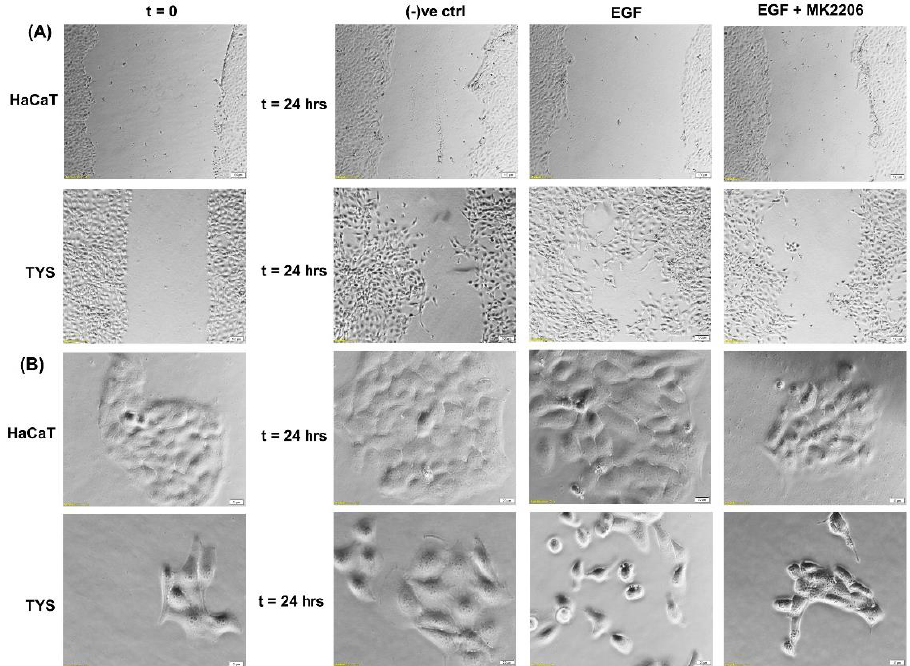
Figure 3. Effect of EGF on oral cancer cell migration. ( A ) A wound was created manually on the cell monolayer as previously described [61] and treated with the EGF with or without the inhibitor for 24 h. EGF stimulated oral adenoid cancer cells (TYS) to close the gap in the wound healing assay (collective cell migration) compared to the negative control. The Akt inhibitor, MK2206, effectively blocked EGF-induced oral cancer cell migration. Normal keratinocytes (HaCaT) were not stimulated to close the gap in response to EGF. Serum-free medium was used as the negative control. Images were captured at t = 0 and at t = 24 h at 50× magnification. ( B ) Cells were plated at low density to form small colonies of cells for the scatter assay as previously described [61] and were then treated with the test conditions for 24 h. EGF stimulated TYS cells to scatter away from the cell colonies (single cell migration) and MK2206 blocked EGF-induced scattering of oral cancer cells. HaCaT did not stimulate scattering in response to EGF. Serum-free medium was used as the negative control. Images were captured at t = 0 and at t = 24 h at 200× magnification. An inverted microscope (Olympus IX70, Tokyo, Japan) with a brightfield camera (SC50) was used to capture the images and CellSense software (Olympus) was used to process the images. The experiments were repeated more than 3 times.